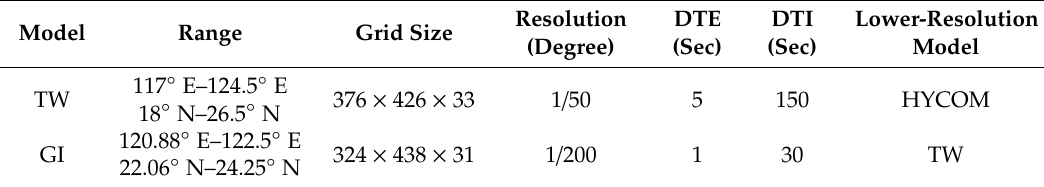
Table 1. The detailed configurations of the nested